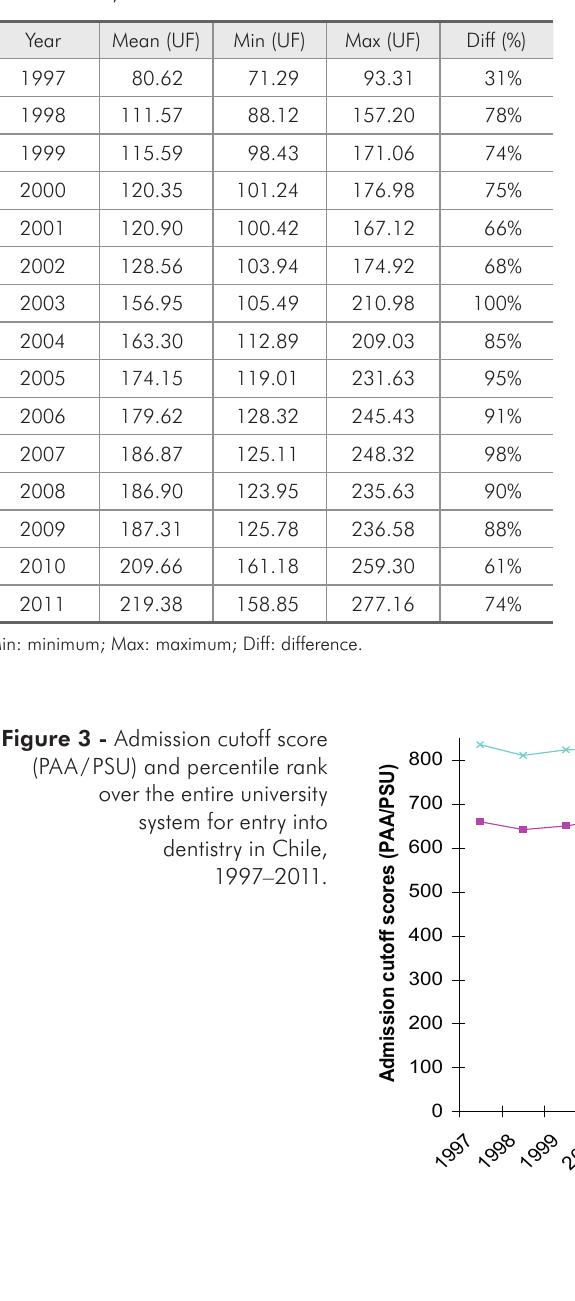
Table 1 - Mean, range and difference of annual dentistry costs in Chile,